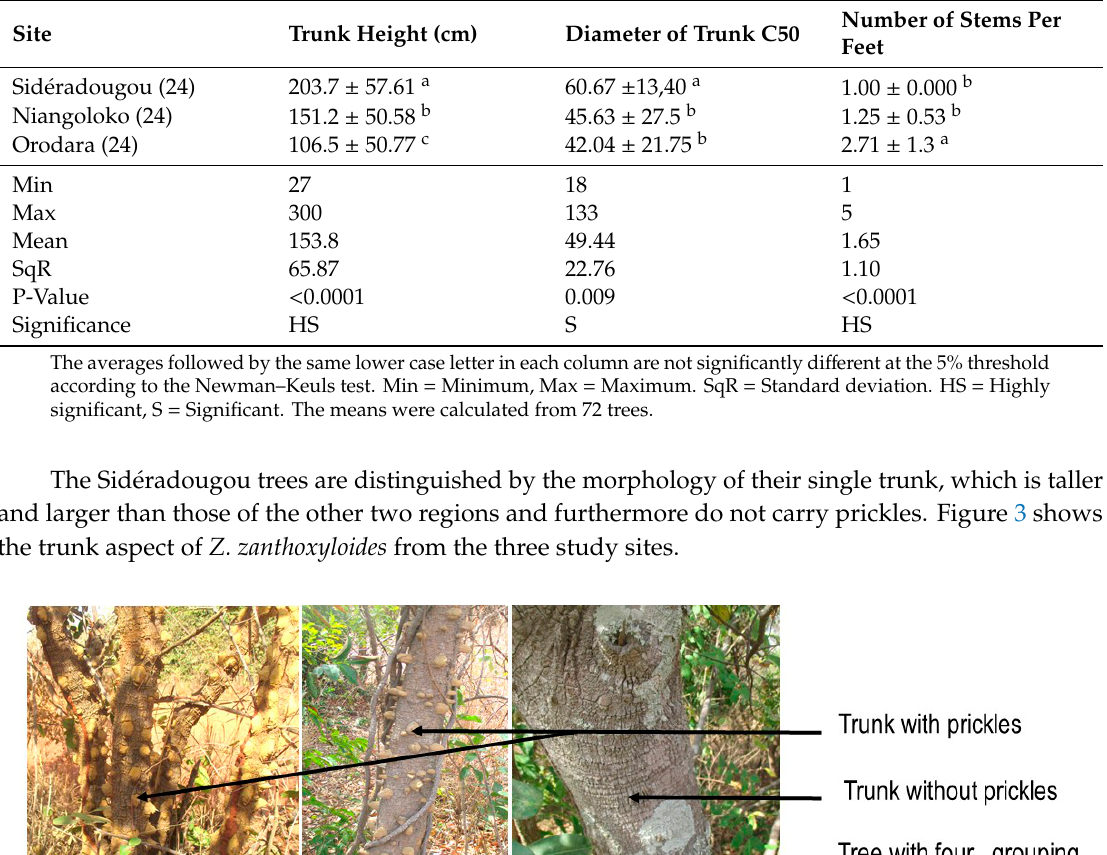
Table 5. Leaf, inflorescence, and seed parameters.